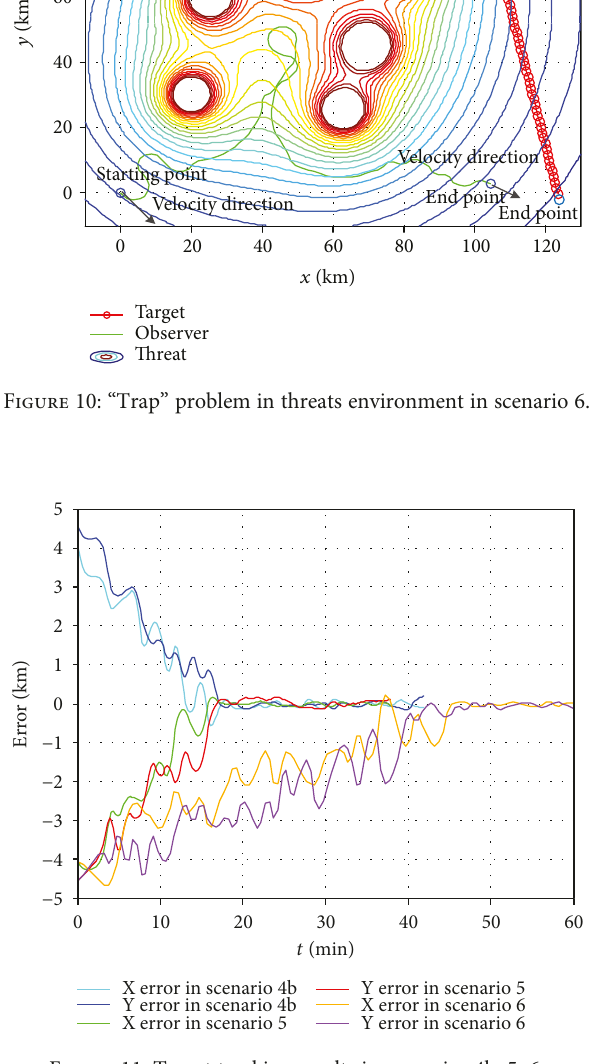
Figure 9: Moving target tracking in scenario 5.